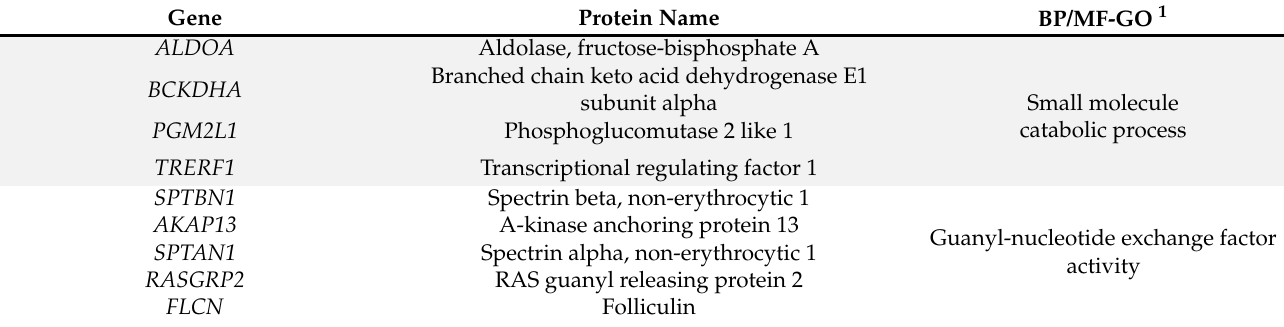
Table 3. Proteins in responder patients with higher phosphorylation before treatment (PRE-R) involved in catabolism and GTPase